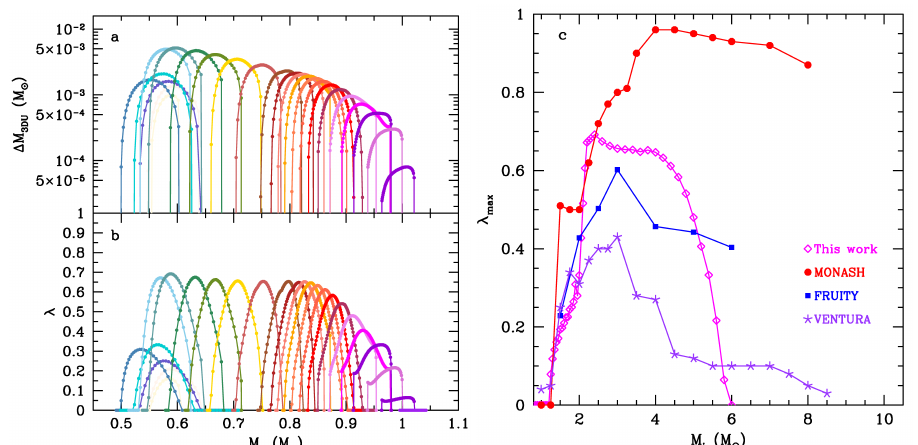
Figure 2. Properties of the third dredge-up in TP-AGB stars at solar metallicity. The IFMR-based calibration of the dredged-up mass ∆ M 3DU ( a ), and efficiency λ ( b ), as a function of the current core mass. COLIBRI TP-AGB models with solar metallicity cover the initial mass range 1.4 (cid:46) M i /M (cid:12) (cid:46) 6.0. ( c ) The maximum efficiency of the 3DU as a function of the initial stellar mass, predicted from various authors, namely: This work [magenta diamonds]; ([30], Ventura, purple stars); ([31,32], Monash, red circles); ([10], FRUITY, blue